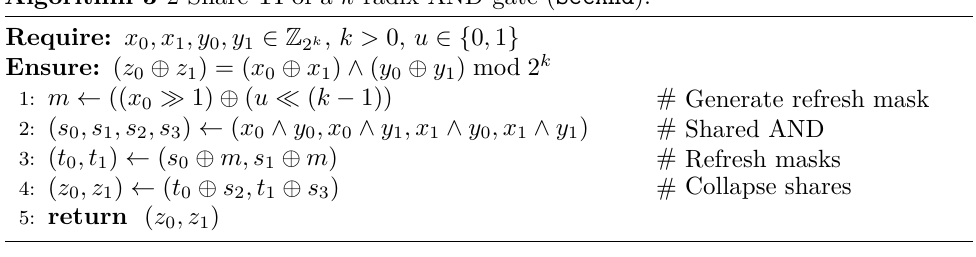
Algorithm 3 2-Share TI of a k -radix AND gate ( SecAnd ).